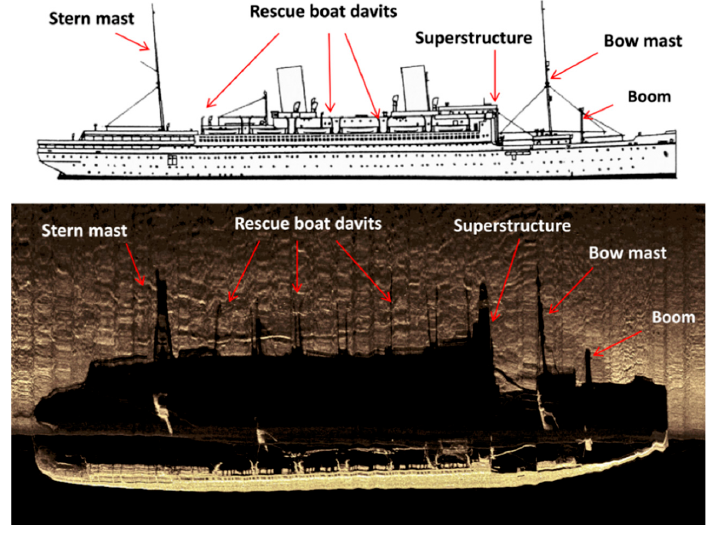
Figure 9. Identification of the wreck’s construction features.